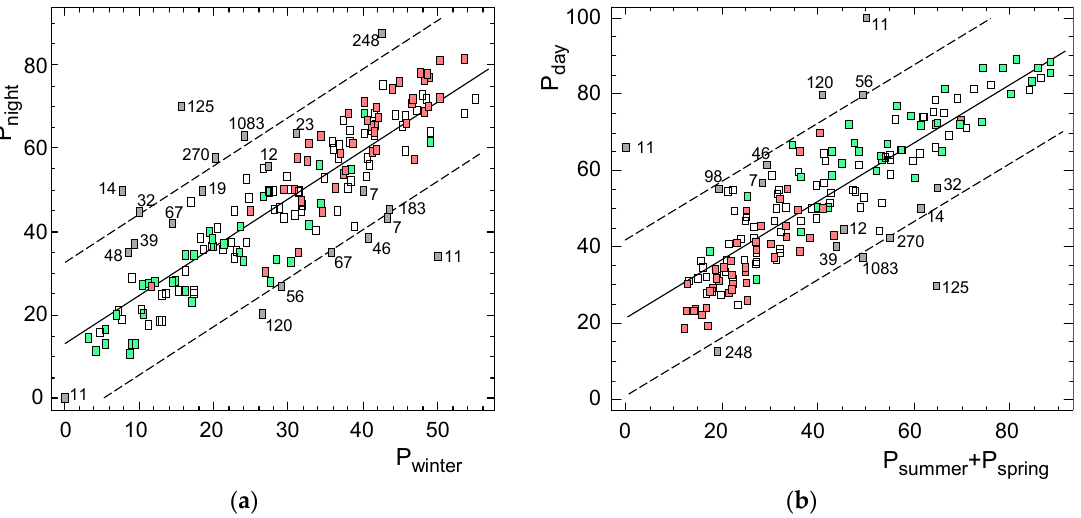
Figure 4. Consumer preferences obtained from Fragrantica’s website for 176 perfumes. ( a ) Percentage of people who preferred the perfume for nighttime wear ( P night ) versus for wintertime ( P winter ); ( b ) percentage of consumers who preferred the perfume for daytime ( P day ) versus for summer ( P summer ) or spring ( P spring ). The fitted regression line is indicated. Dashed lines correspond to prediction limits with a confidence level of 95%. Values next to each observation (points filled in gray) indicate the number of consumers who provided this information. Points filled in red: perfumes rated as I EDoriental = 1; in green: those with ( X green + X citrus ) > 3.